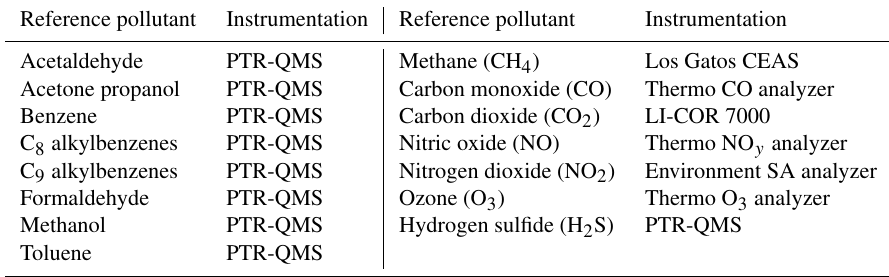
Table 1. Reference data utilized in this analysis and the instruments used to collect those data.